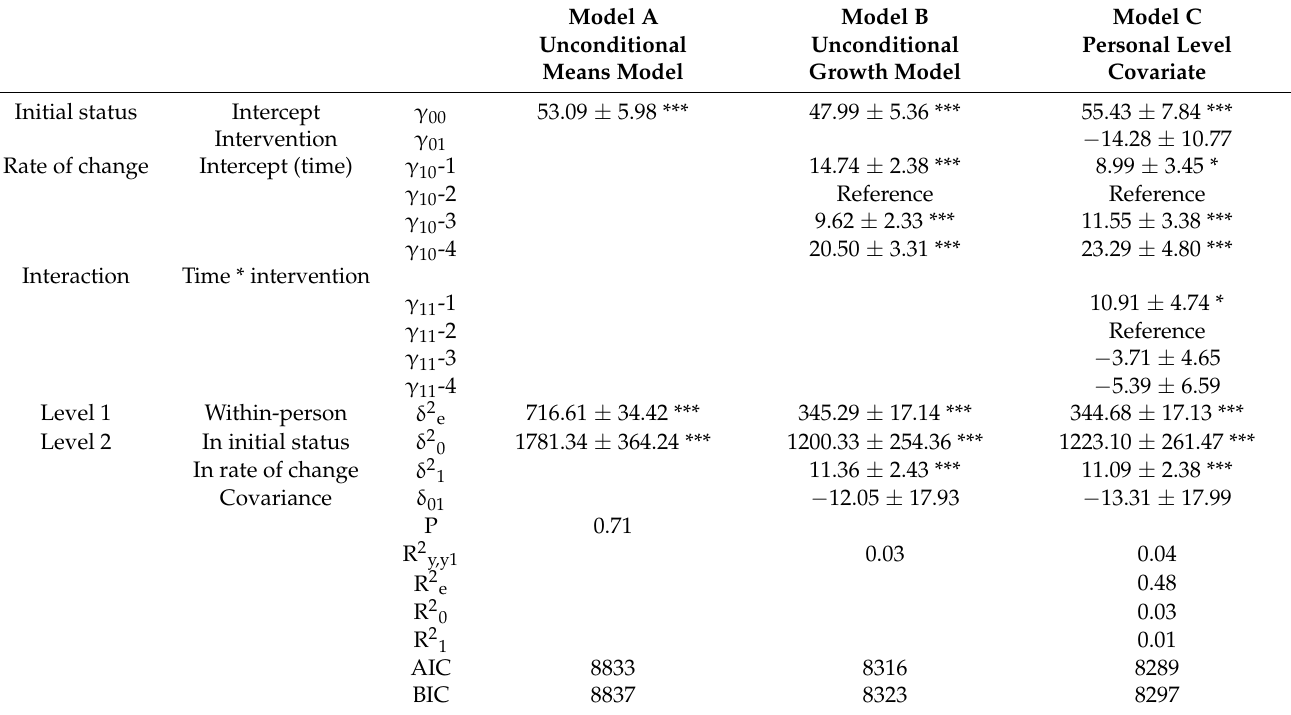
Table 5. Mixed model analyses of variations in moderate-intensity physical